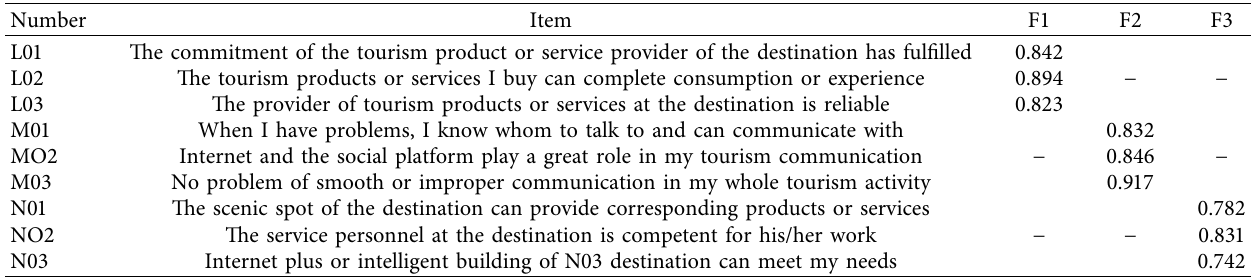
Table 3: Response factor analysis of tourists’ behavior.